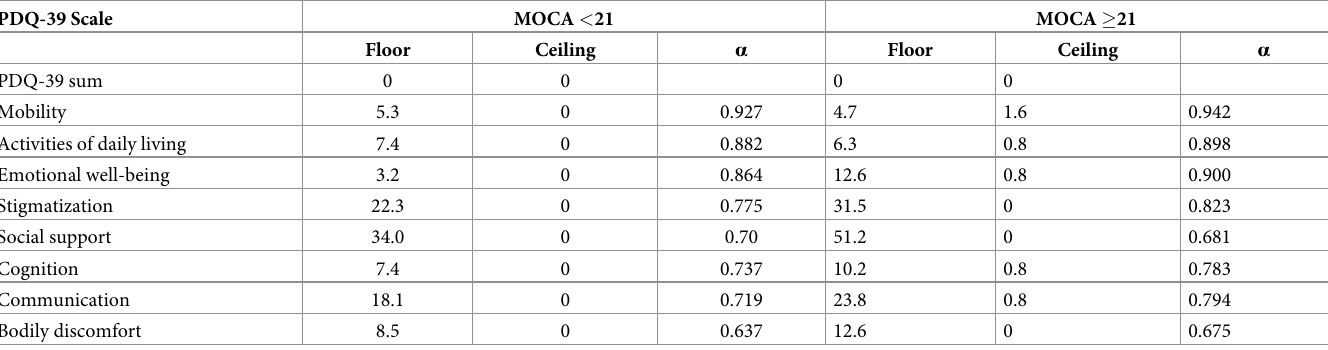
Table 2. Parkinson’s Disease Questionnaire-39 scores and internal consistency in people with low and high Montreal Cognitive Assessment